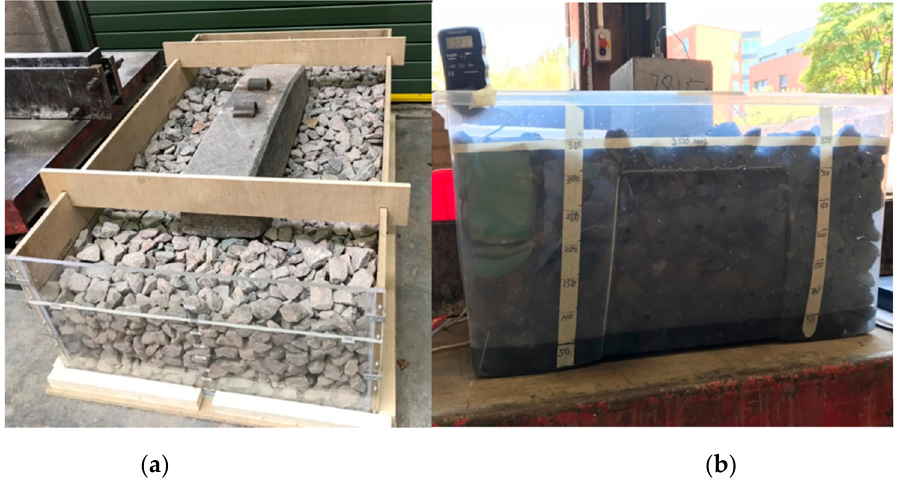
Figure 4. ( a ) Large-scale ballast bed. ( b ) Small-scale ballast bed.